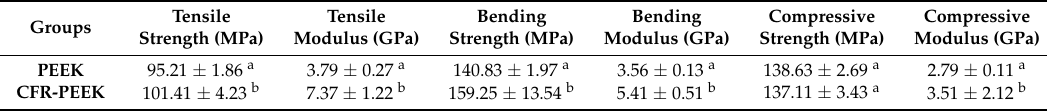
Table 3. Mechanical properties (means ± standard deviation) of PEEK and CFR-PEEK.